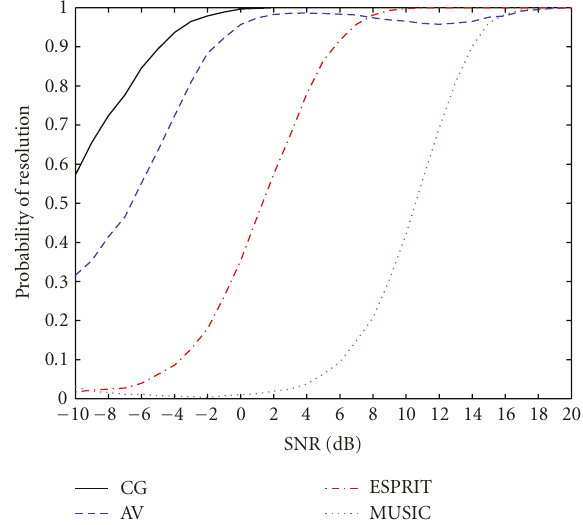
Figure 2: Probability of resolution versus SNR (separation 3 ◦ , K =